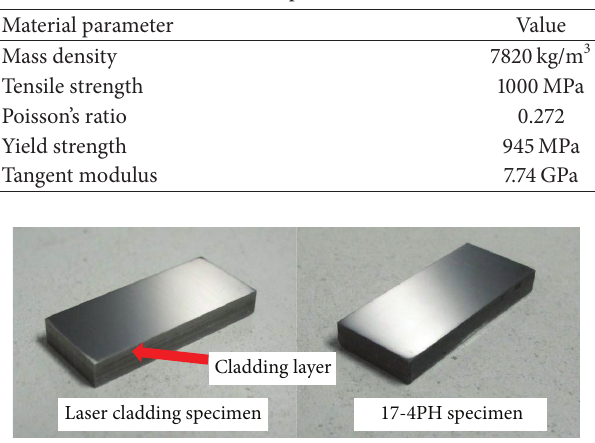
Figure 4: Photo of the